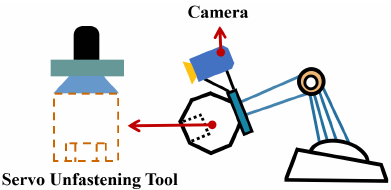
Figure 3. Scheme of the proposed screw disassembly system. Table 1. Comparison between the previously reported methods and the proposed